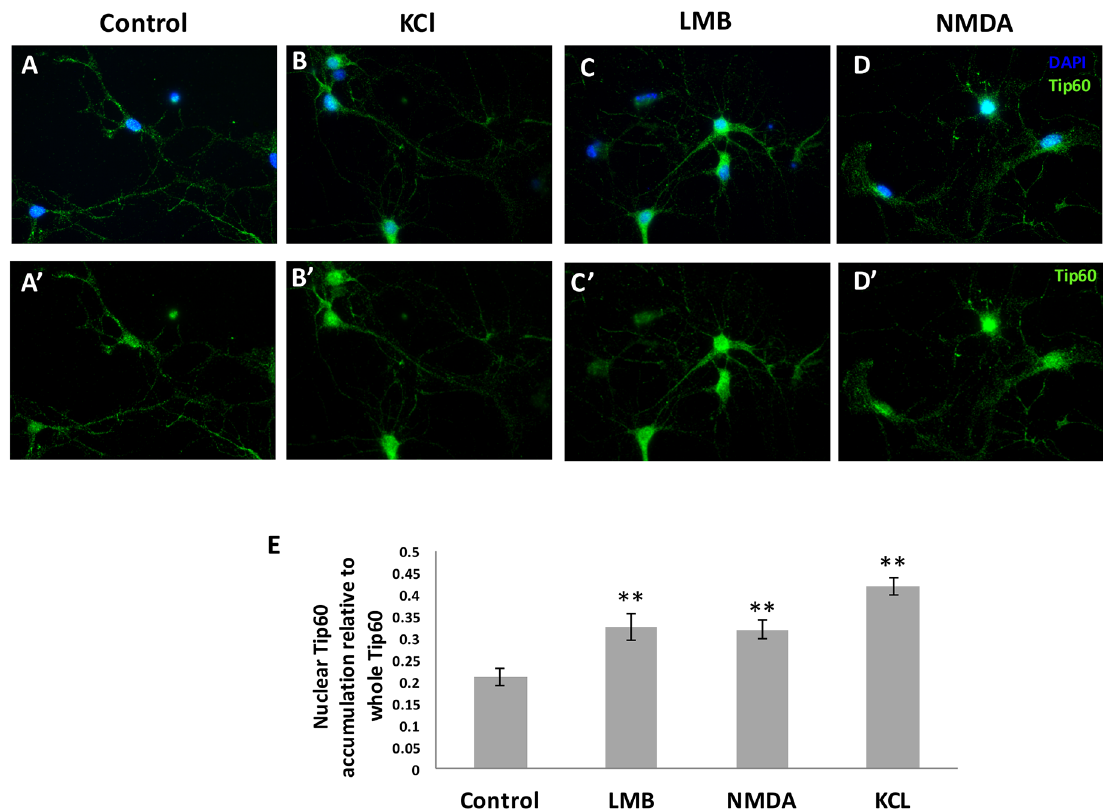
Fig 7. Extracellular stimulation of hippocampal neurons induces Tip60 nuclear import. (A, A ’ ) Tip60 distribution in nucleus and cytoplasm under resting conditions. (B-D; B ’ -D ’ ) Rat Hippocampal neurons (DIV6) treated with depolarizing agent NMDA immunostained with Abs to Tip60, Tau(cytoplasm) and DAPI(nucleus). (E)Quantification of fluorescent signal intensity for nuclear Tip60 in neurons treated with Leptomycin B(LMB) that blocks nuclear export, or depolarizing agents NMDA or KCl. Neurons (n = 50) were analyzed per treatment. Data represents the mean of 50 replicates. One-way ANOVA was used to determine statistical significance between control and each of treatment conditions. ** P < 0.01, * P < 0.05. Error bars indicate